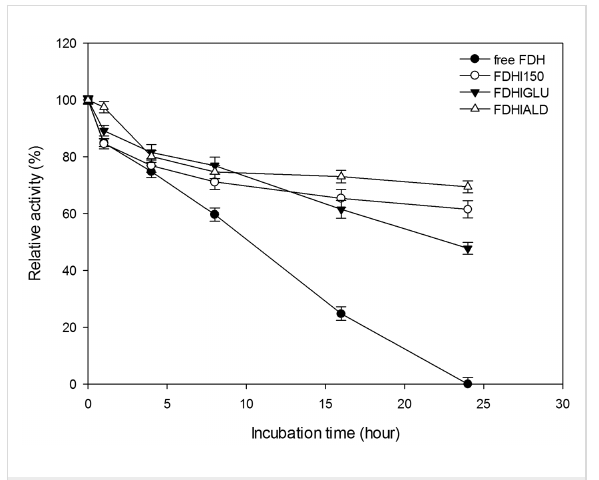
Figure 4: Thermal stability of free and immobilized FDH preparations at 35 °C.